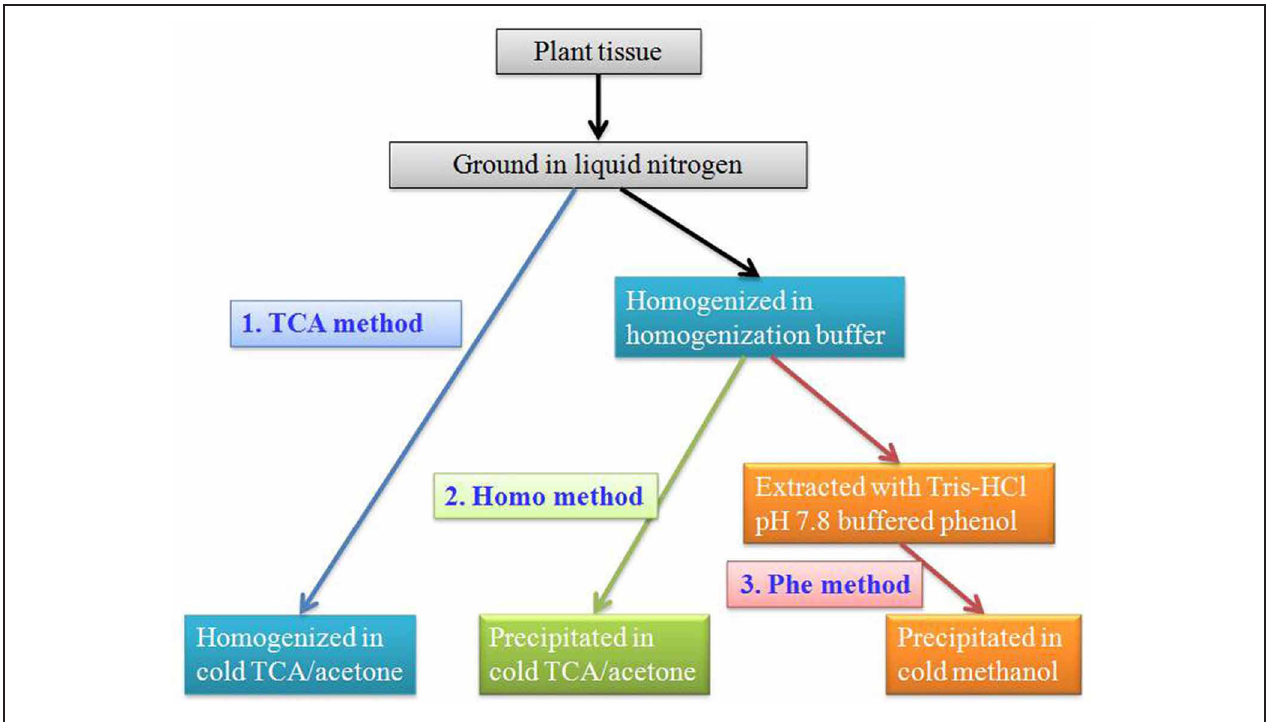
FIGURE 1 | Protein extraction protocols for